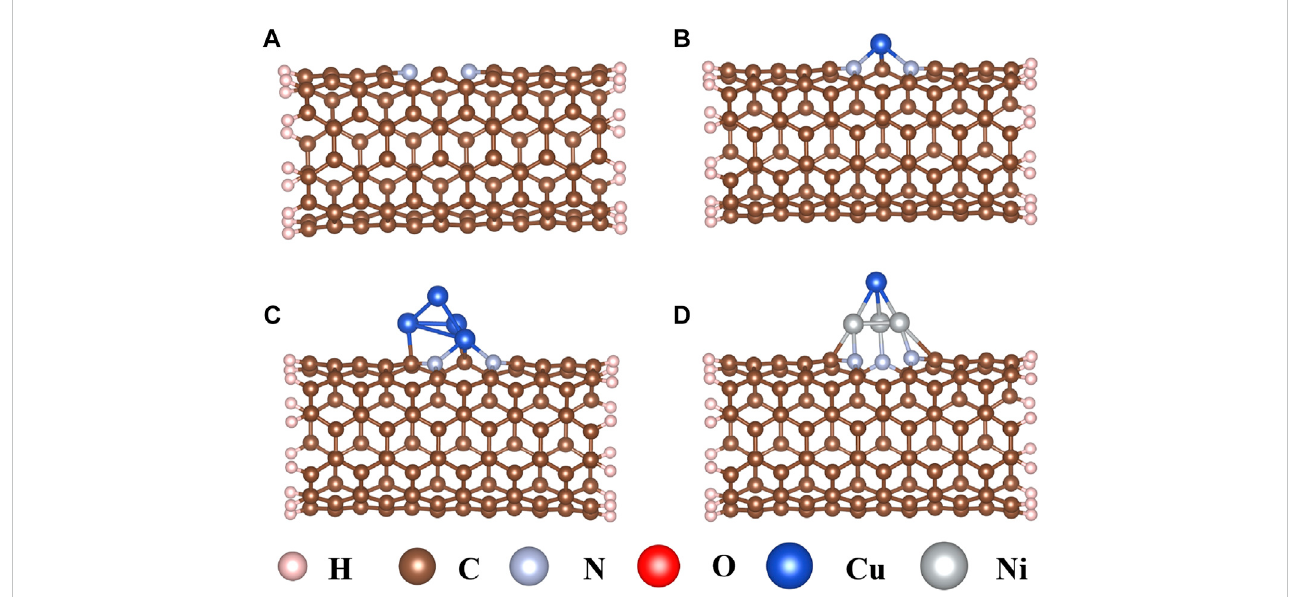
Optimized structures of (A) nitrogen-doped carbon nanotubes, (B) single Cu atom (Cu@CNTs), (C) Cu 4 cluster (Cu 4 @CNTs), and (D) CuNi 3 (CuNi 3 @ CNTs) supported on the nitrogen-doped carbon nanotubes.